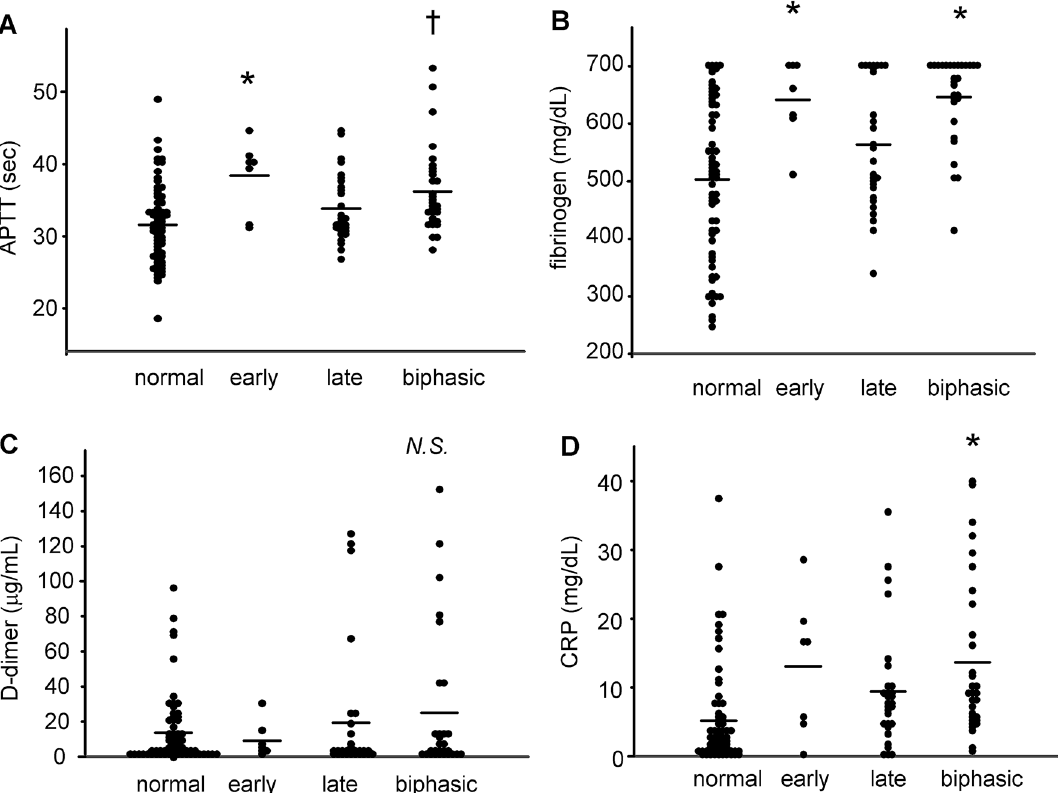
Figure 3. Differences in laboratory data related to coagulation among the patterns of APTT second-derivative curves. ( A ) APTT, ( B ) plasma fibrinogen levels, ( C ) D-dimer levels, and ( D ) CRP levels in specimens with normal, early shoulder, late shoulder, and biphasic patterns of APTT second-derivative curves. * P < 0.05 vs. normal, † P < 0.01 vs.